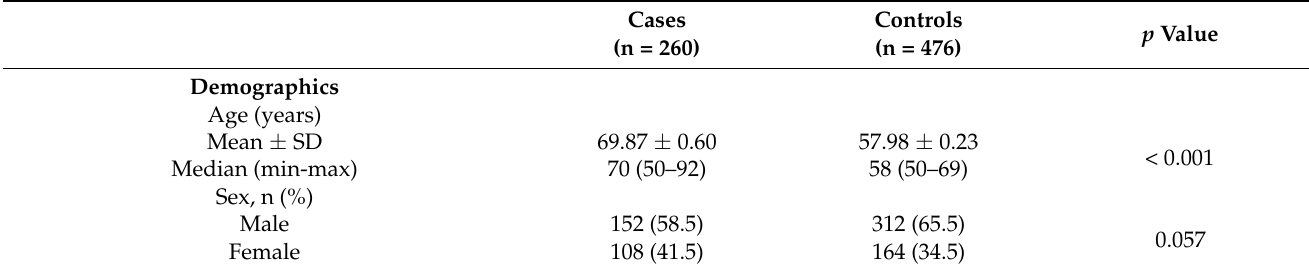
Table 1. Description of